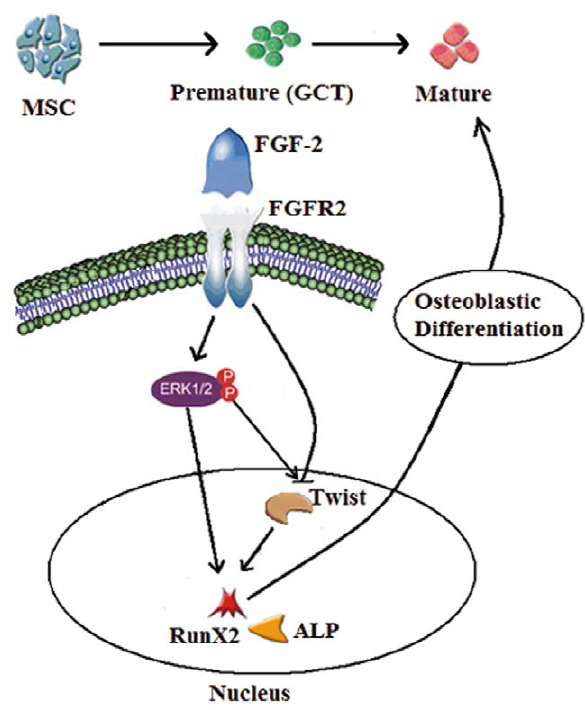
Figure 8. Proposed signaling mechanisms representating the osteogenic differentiation model induced by FGF-2 in GCT stromal cells. FGFR2-IIIc is activated by FGF-2, which in turn increases ERK1/2 signaling in GCT stromal cells. ERK1/2 activates Rux2 expression and suppresses TWIST1 expression, thus stimulating osteoblastic